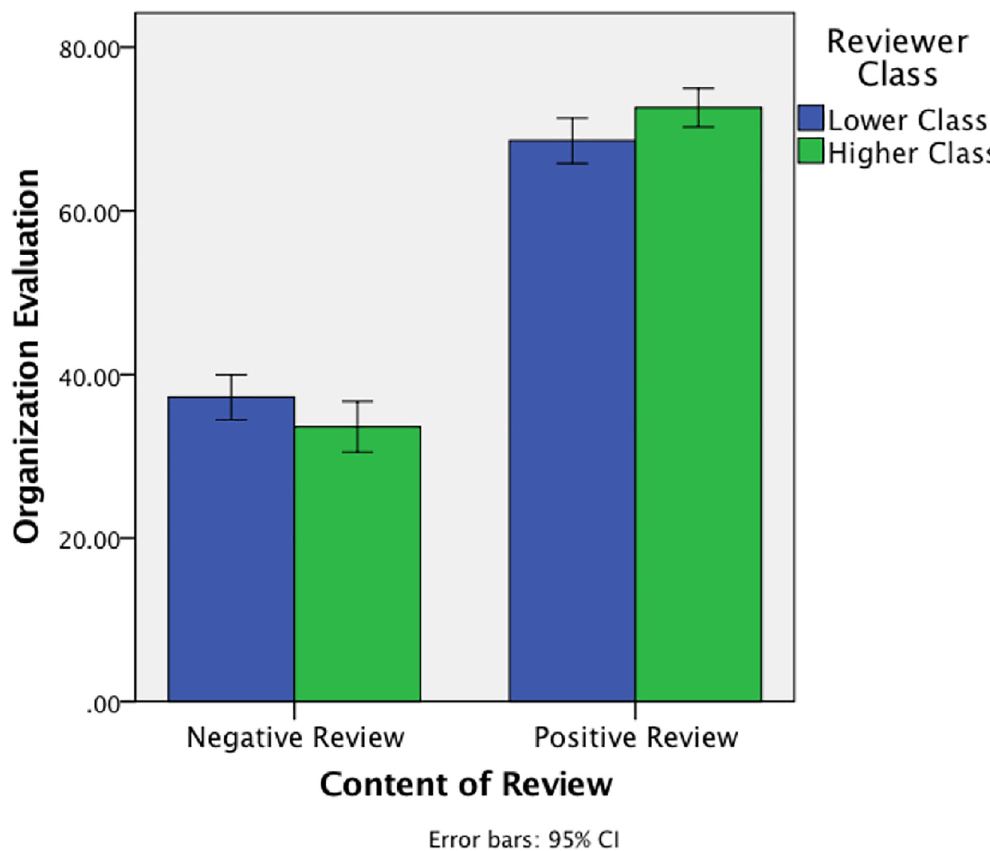
Fig 5. Means from Study 3 showing the interaction between review Positivity and Reviewer Class, collapsed across Organization Status conditions.